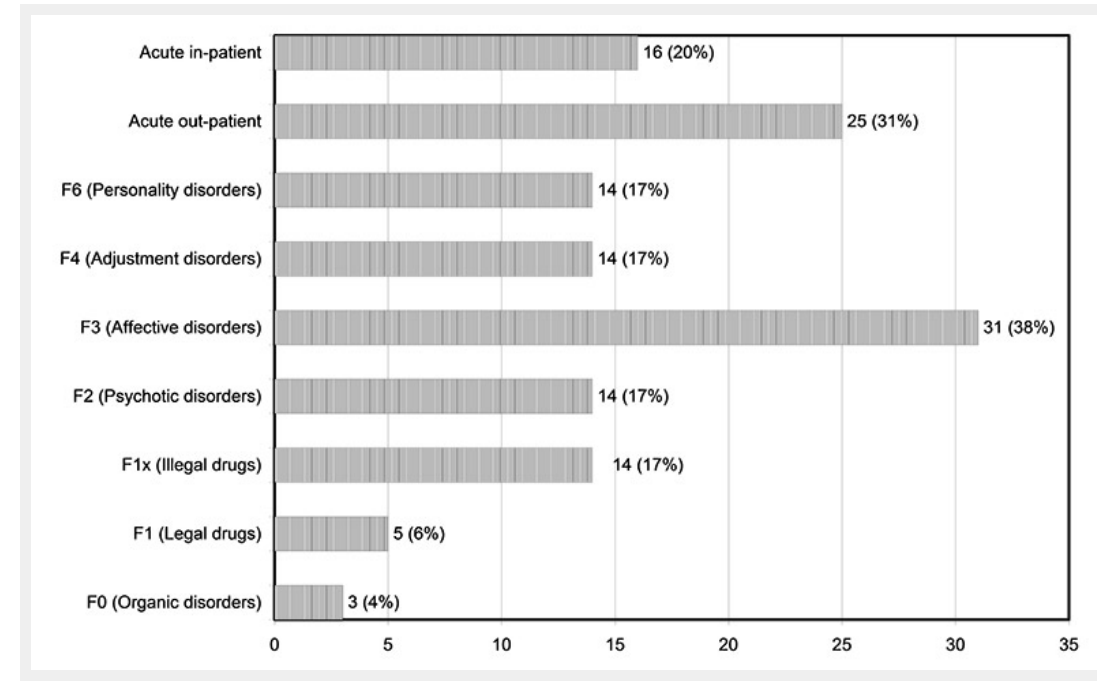
Figure 3 Psychiatric Diagnoses and Relevant Information on Suicides with Psychiatric Files (n = 81).